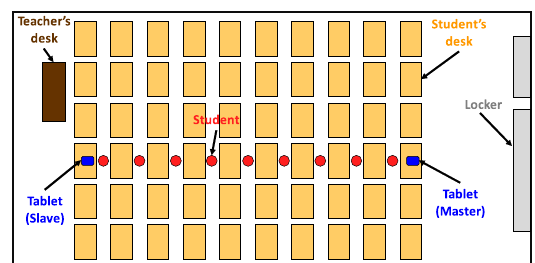
Fig. 9 Environment for survey on influence of human presence (9 stu- dents)